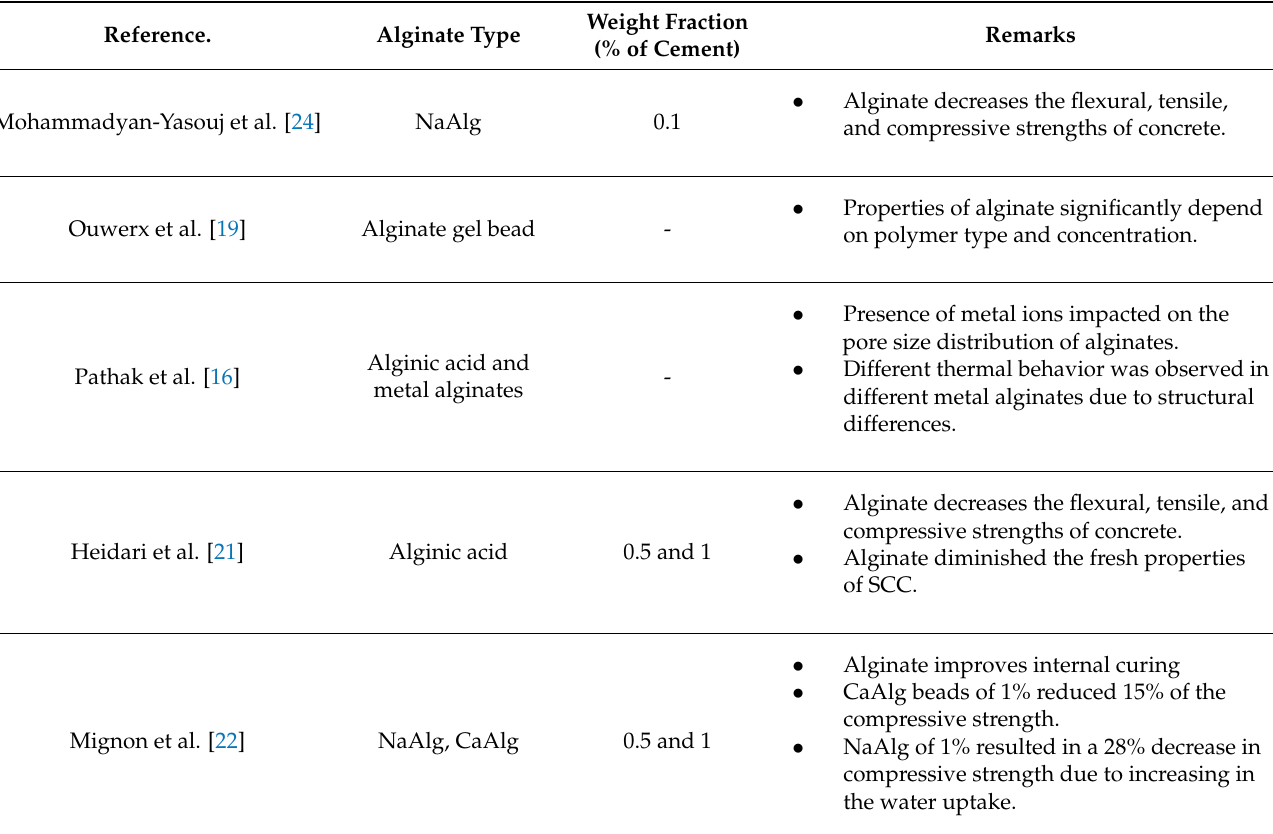
Table 1. A summary of the studies on the effect of alginates on mechanical parameters of concrete.